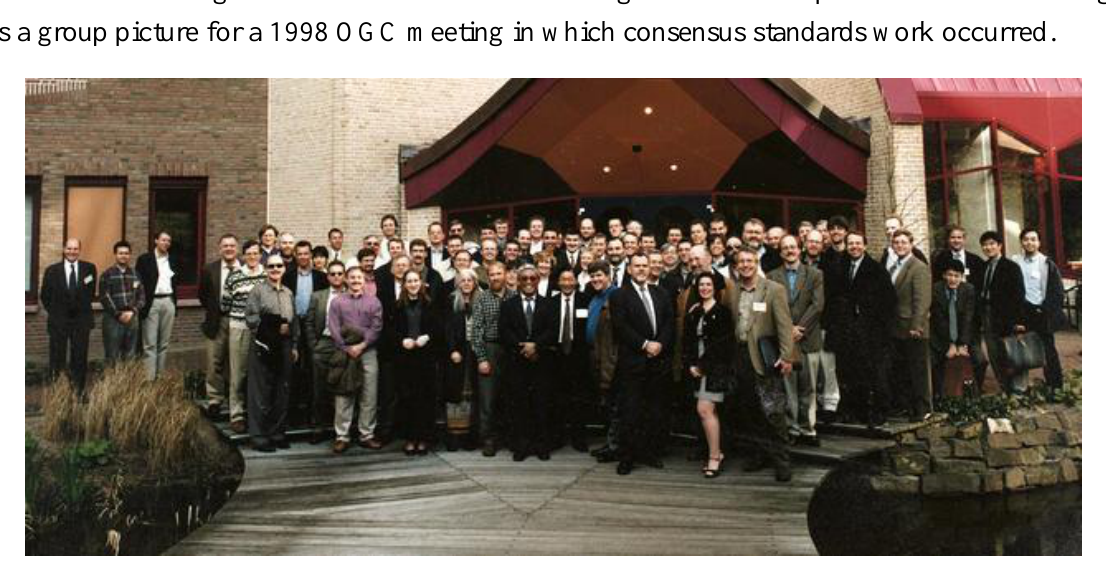
Figure 1. Early OGC Meeting, Enschede Netherlands 1998